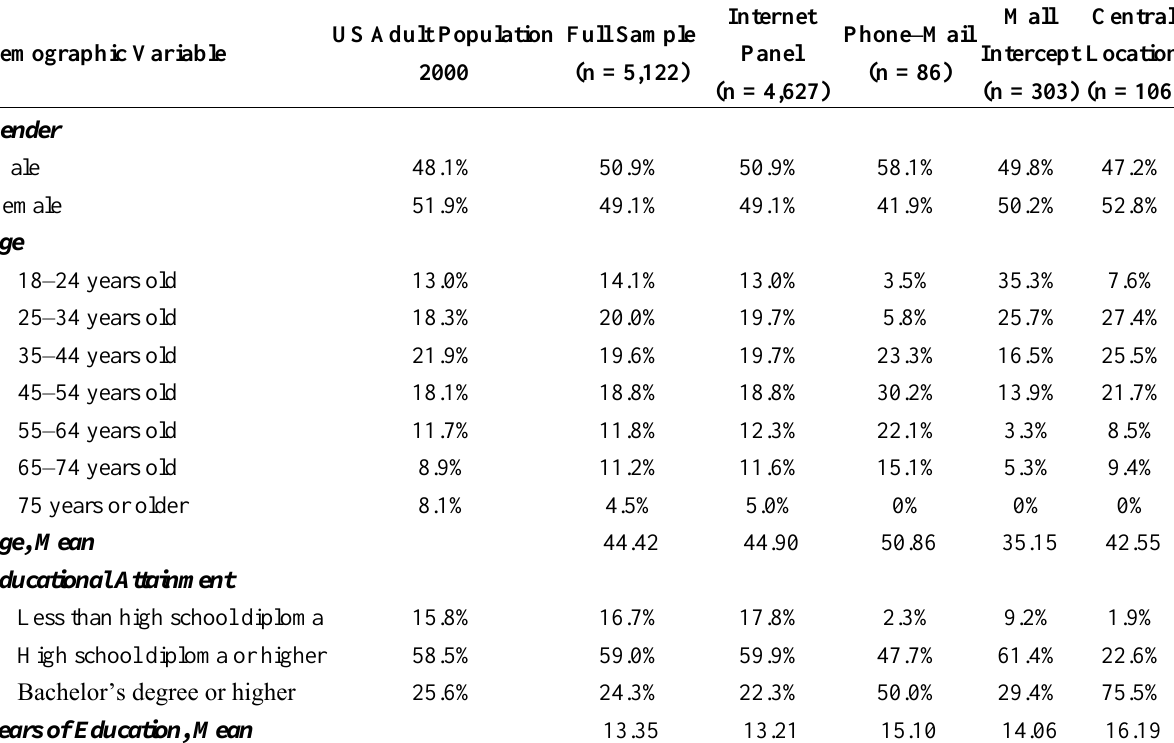
Table 2. Comparison of sample to the national adult U.S. population a